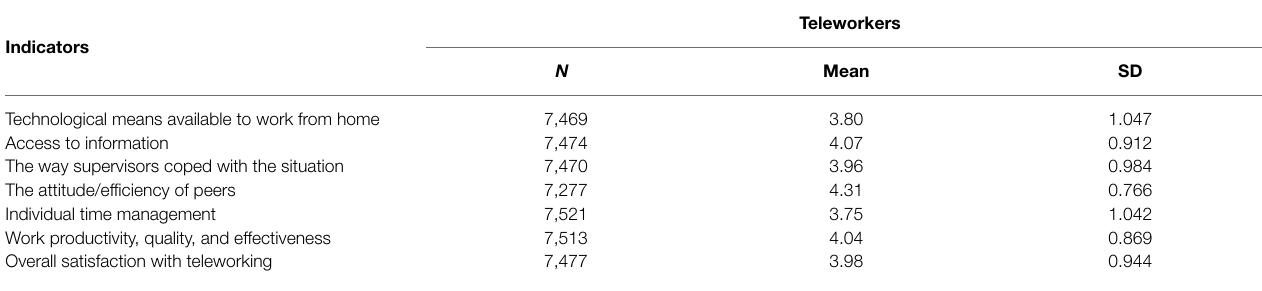
TABLE 4 | Descriptive statistics for teleworking conditions (only teleworkers subsample).